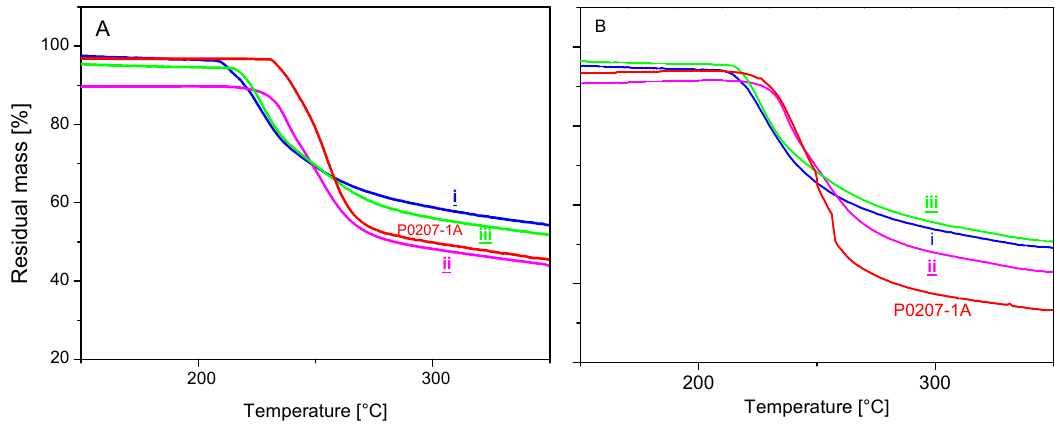
Figure 11. TG (thermogravimetry) records of four biopolymeric samples. The